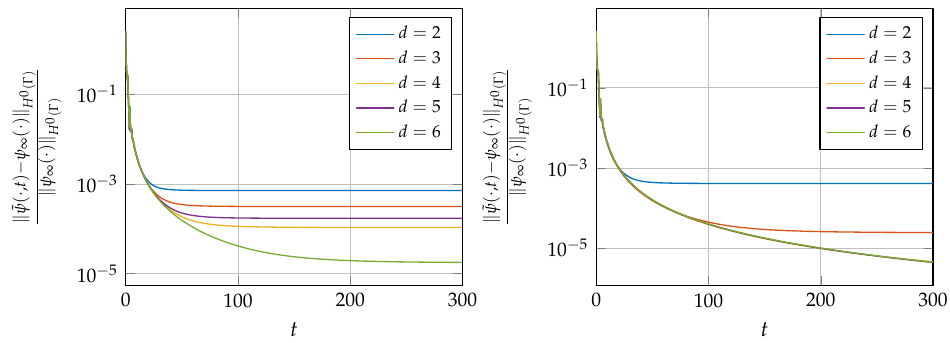
Figure 17. Time history of the relative error between transient and stationary solution in H 0 ( Γ ) norm for increasing degrees of B-spline (left) and Lagrangian (right) shape functions on a uniform spatial discretization of size ∆ x = 0.2. The time interval [ 0, T ] = [ 0,300 ] has been decomposed into 1500 time steps of size ∆ t = 0.2. Table 9. Relative error in H 0 ( Γ ) norm at final time T = 300 for B-spline and classical Lagrangian shape